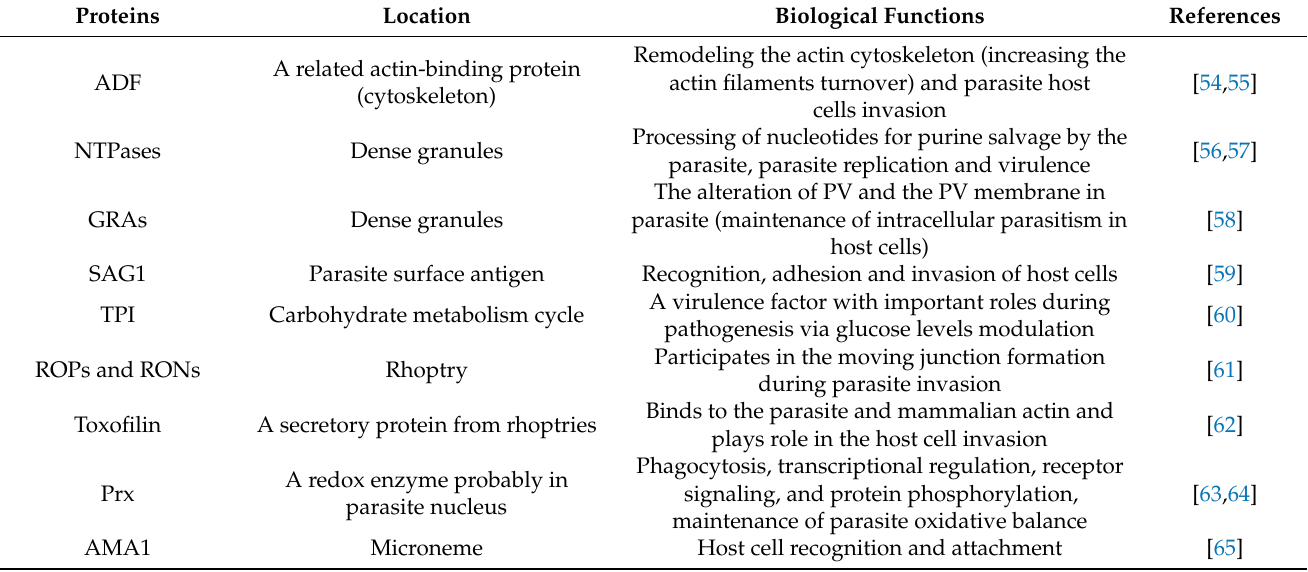
Figure 2. Toxoplasma vaccine and diagnostics candidates inferred from proteomics data.